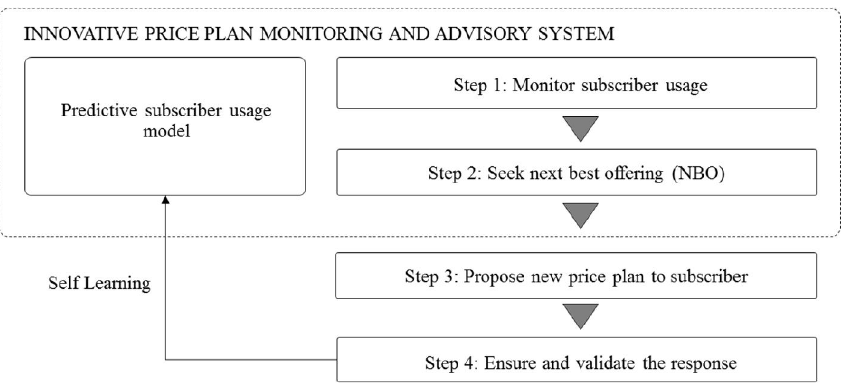
Fig. 4. The procedure and methodology for application validity test